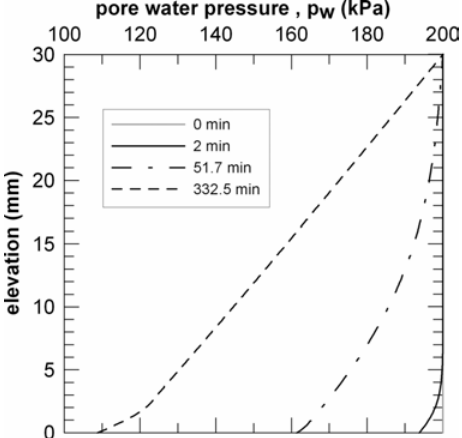
Fig. 15 – Electrokinetic consolidation test: isochrones of water pressure for gas production at the anode η . with 1. = 0